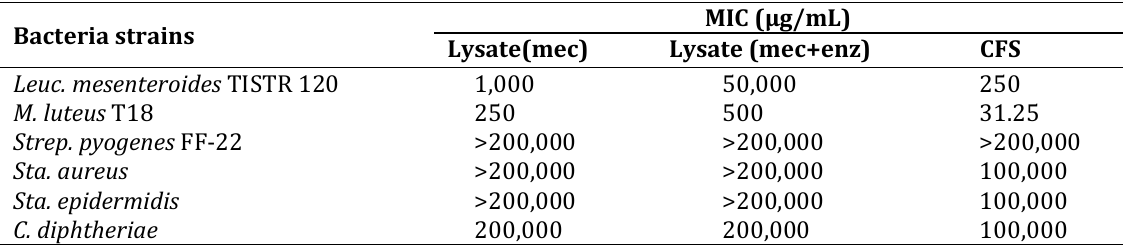
Figure 1. The lysate production process of Streptococcus macedonicus MBF10-2 fermentation using both mechanical and enzymatic methods for disruption and freeze-drying. A) after disruption and separation by centrifugation, the lysate appeared as cloudy liquid-fraction; and B) after freeze-drying, the lysate powder turned into white to yellowish white. S, by ultrasonication; ES, by enzymatic and ultrasonication treatments. Table I. Minimum Inhibitory Concentration (MIC) of cell lysate against indicator strains and cell free